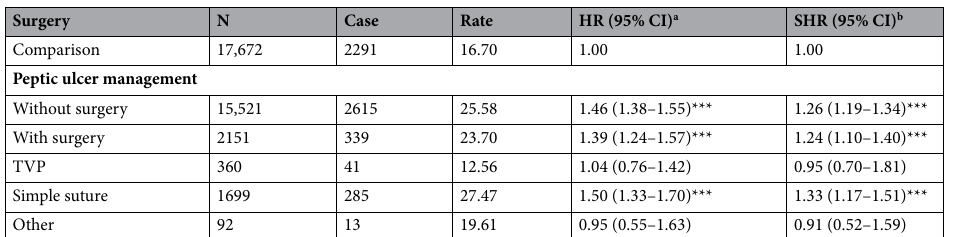
Table 3. Multivariable Cox method measured hazard ratio of BPH in comparison cohort and peptic ulcer patients by surgery. HR hazard ratio, CI confidence interval, SHR subdistribution hazard ratio, TVP truncal vagotomy and pyloroplasty. Rate, per 1000 person-years. *p < 0.05, **p < 0.01, ***p < 0.001. a Using Cox proportional hazard regression after adjusting for age, and all comorbidity. b Using Cox proportional hazard regression with competing risk (death) after adjusting for age, and all